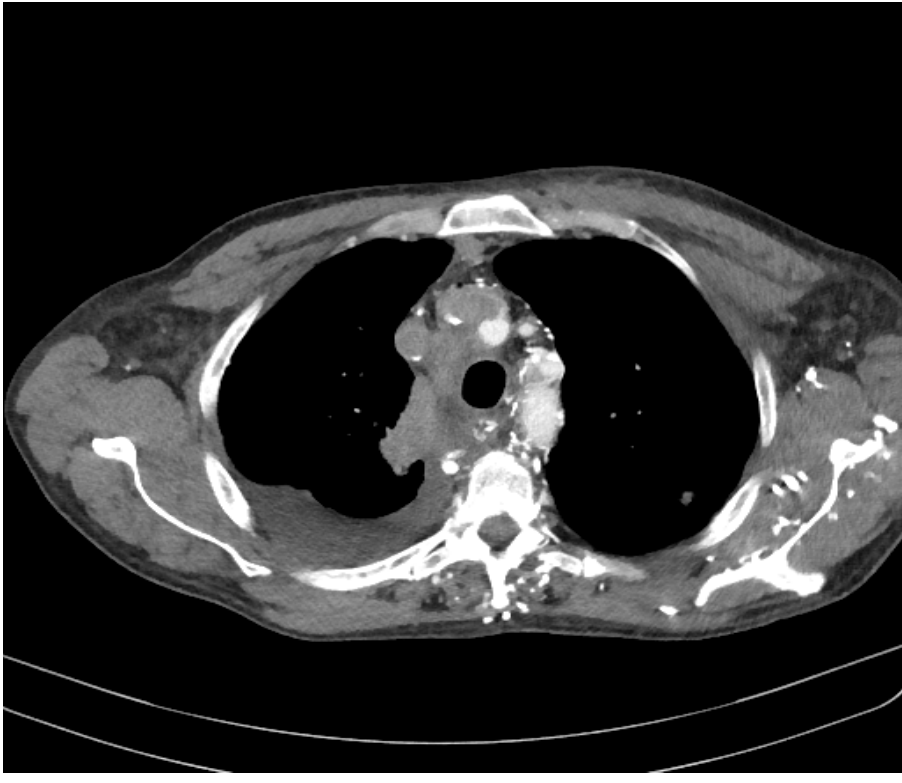
Figure 6. Computer tomography of the patient.